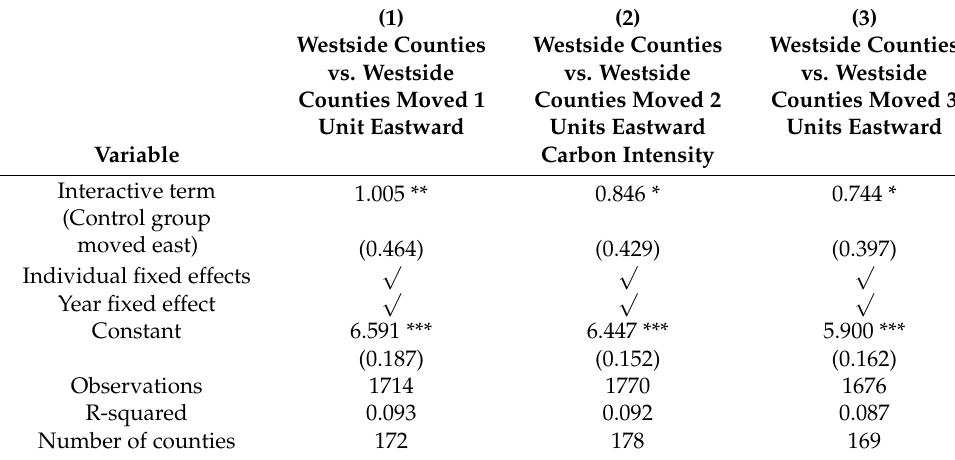
Table 6. Tests for changing the reference group.